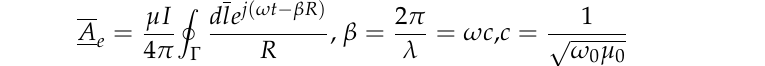
(cid:48) are the distances